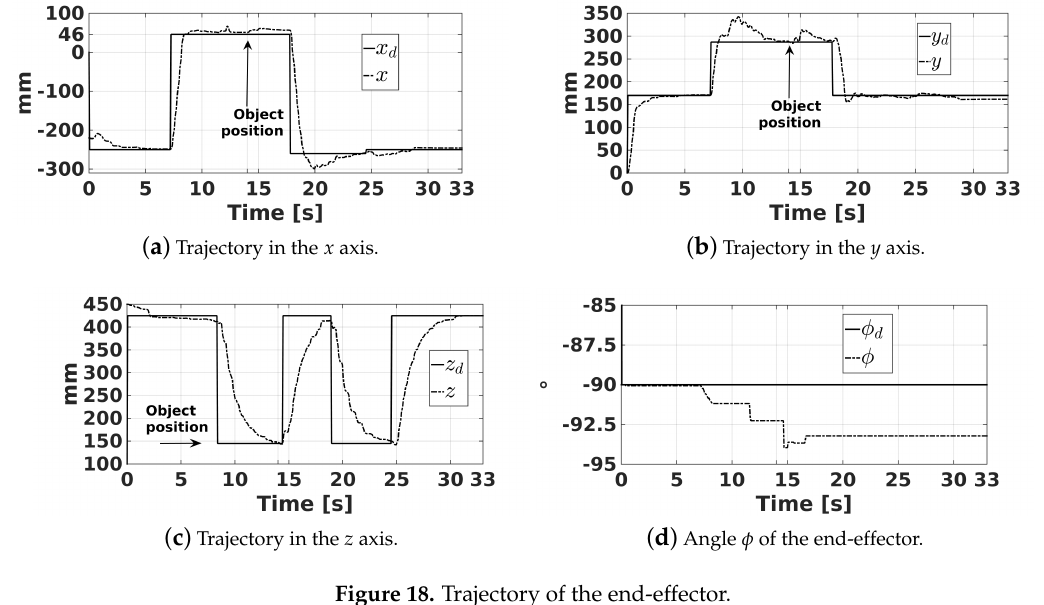
Figure 18. Trajectory of the end-effector.